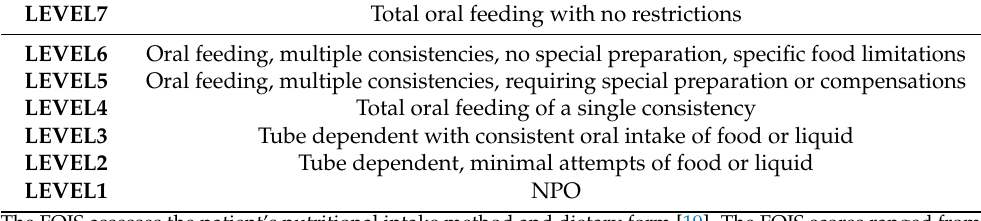
Table 1. Functional oral intake